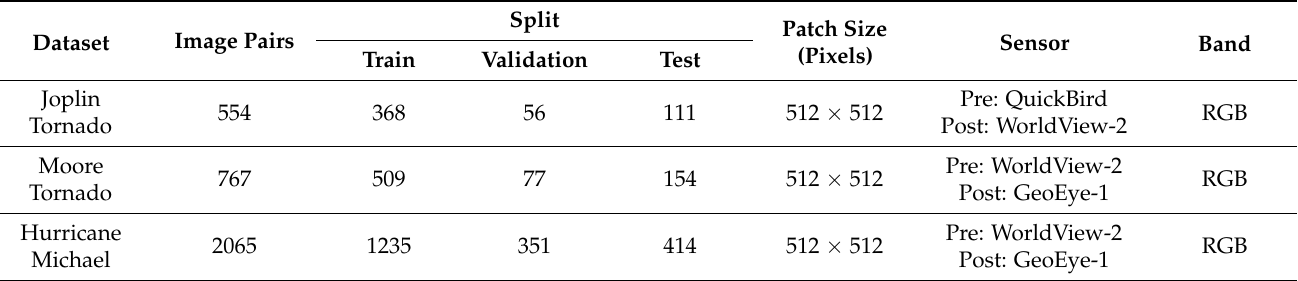
Figure 5. Composition of the xBD dataset. ( a ) Pre-disaster image, ( b ) post-disaster image, ( c ) building mask, and ( d ) building damage mask. Table 1. Overview information of datasets in the